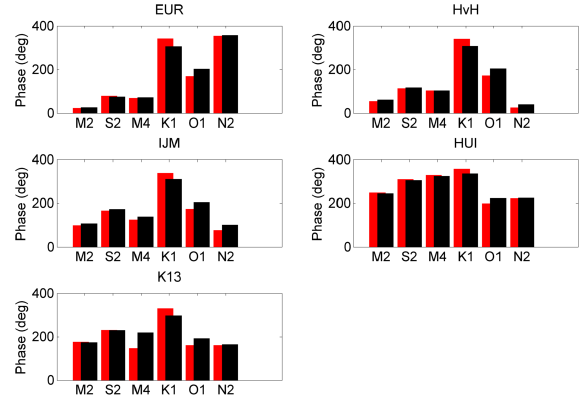
Figure 6. Tidal phase comparison for six tidal constituents: black – observation; red – computed.